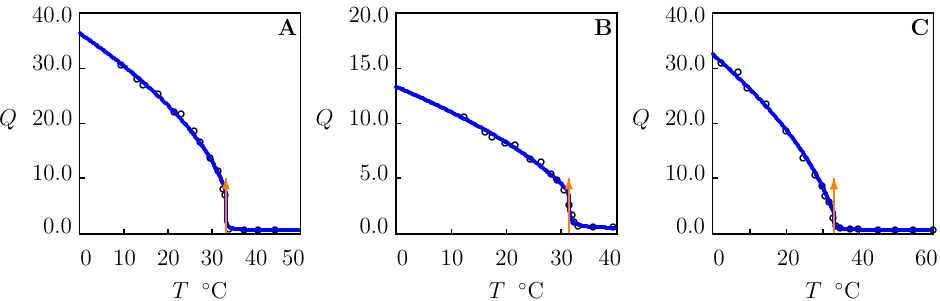
Figure 3. Equilibrium degree of swelling Q versus temperature T . Circles: experimental data on PNIPAAm gel (( A )—[63]) and microgels (( B )—[30], ( C )—[40]) in water. Solid lines: results of numerical analysis. Arrows indicate the volume phase transition